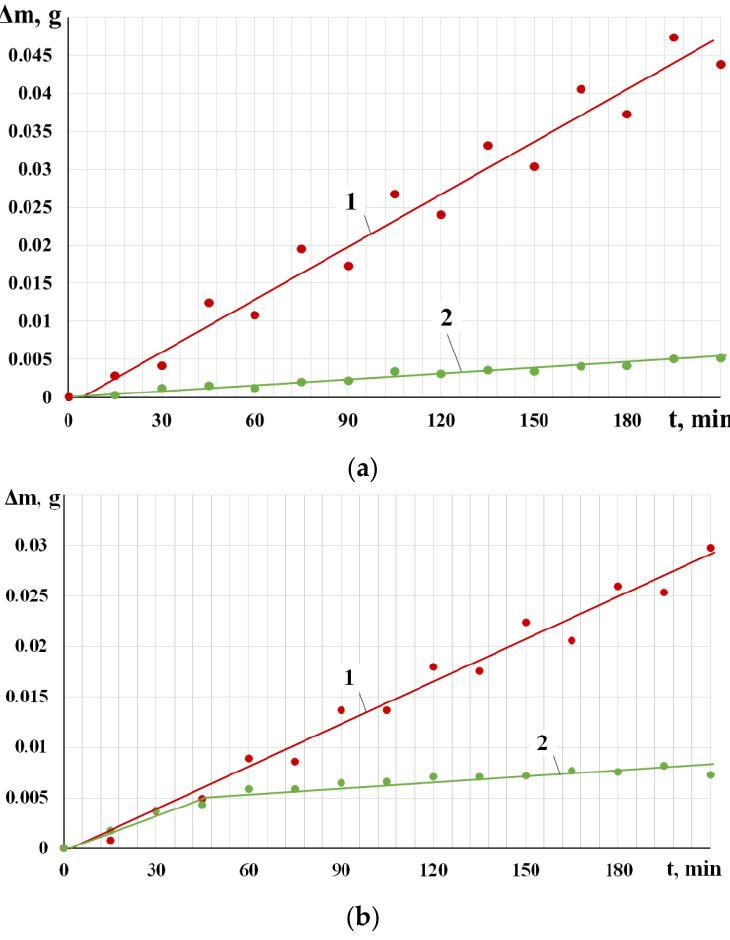
Figure 1. Solid particle erosion curves of steel 20GL: ( a ) impact angle of 30°; ( b ) impact angle of 90°. 1 — no modification, 2 — boriding [35].